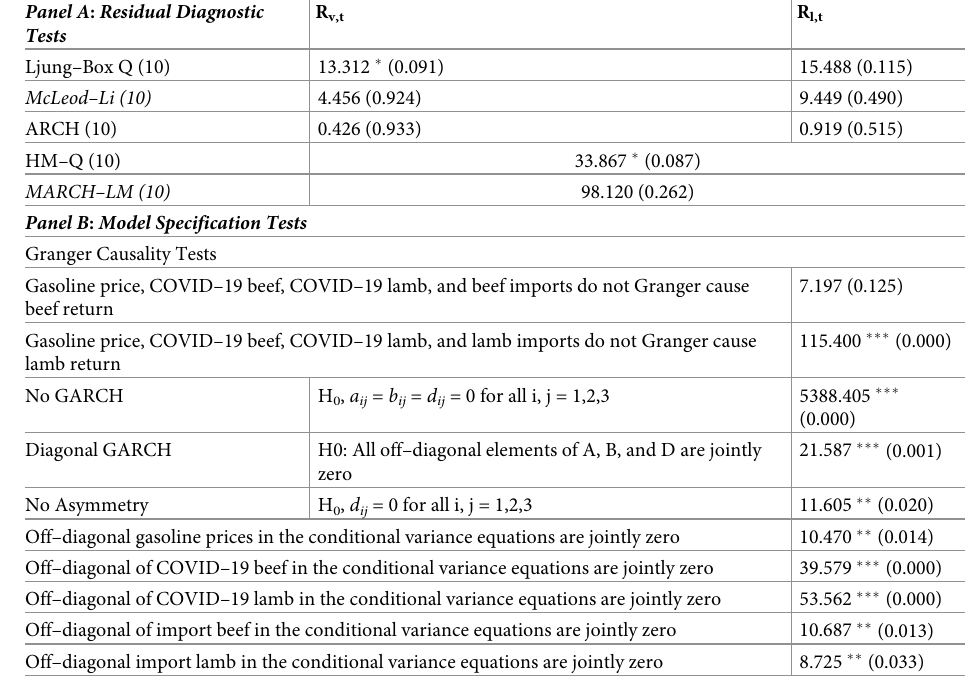
Table 4. Parameter estimates for conditional variances in VAR–Asymmetric BEKK BGARCH. Panel A : Residual Diagnostic